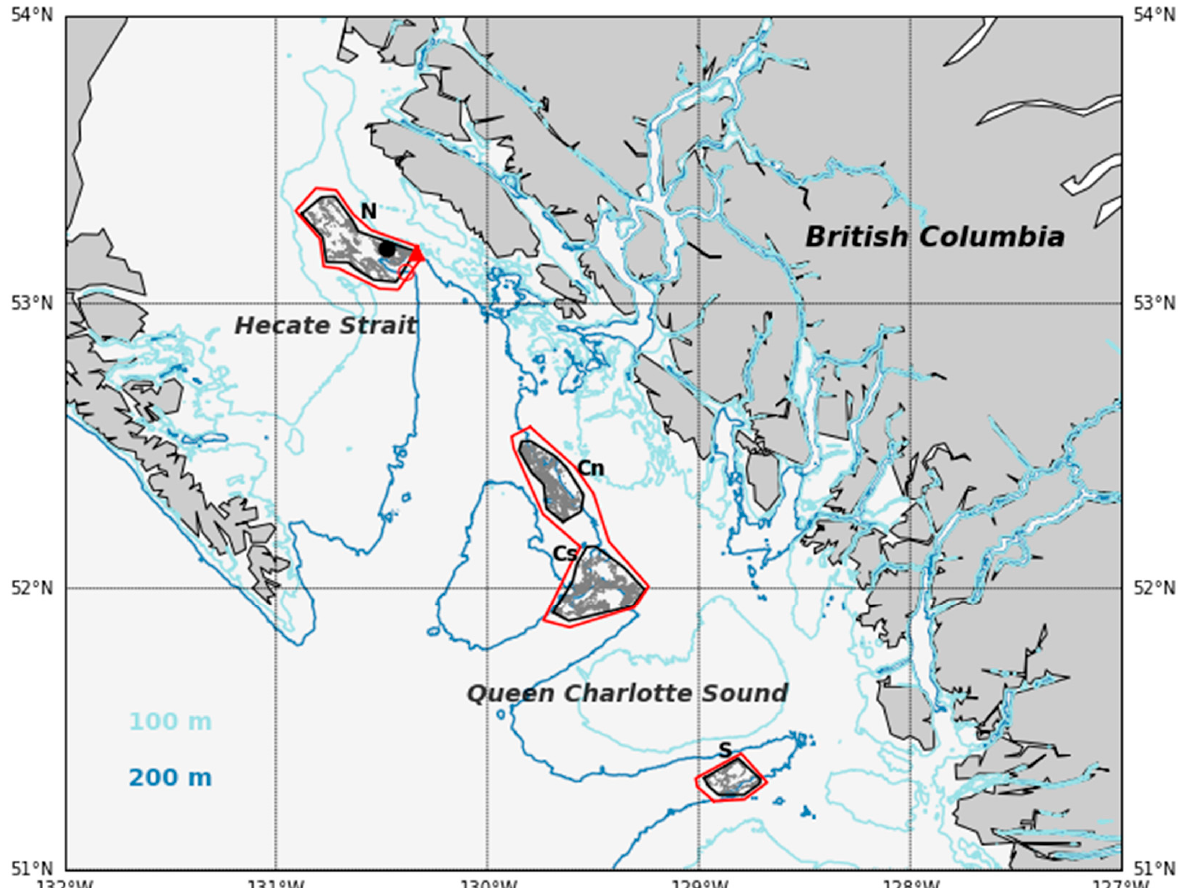
Figure 1. Map of the HSQCS located in British Columbia, Canada, showing the locations and names of the four glass sponge reefs (grey lines) enclosed by the core protection zones (CPZs, black polygons) and the adaptive management zones (AMZs, red polygons). N, Cn, Cs, and S represent the northern, central northern, central southern, and southern reefs, respectively. The triangle depicts a vertex of the core protection zone for the northern reefs. The open circle and solid circle depict the location of current measurements.